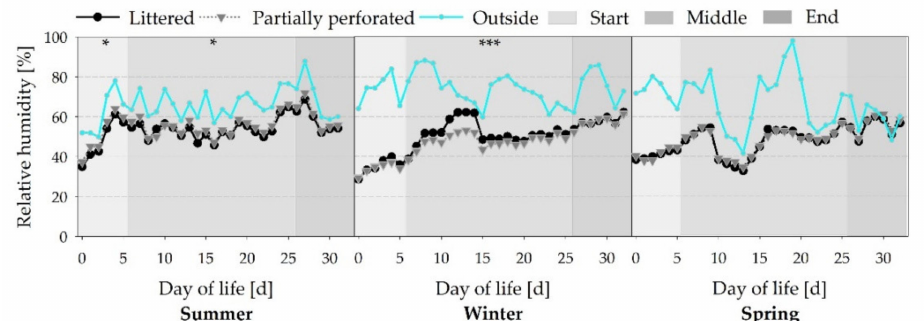
Figure 5. Average daily relative air humidity inside the broiler houses with two different floor types, and the outside environment RH measured over three different fattening periods ( n = 144 values per day and barn). Significant differences between both floor types within the three different sections (start, middle, end of the fattening period) are marked by asterisks: * p ≤ 0.05, *** p < 0.001.